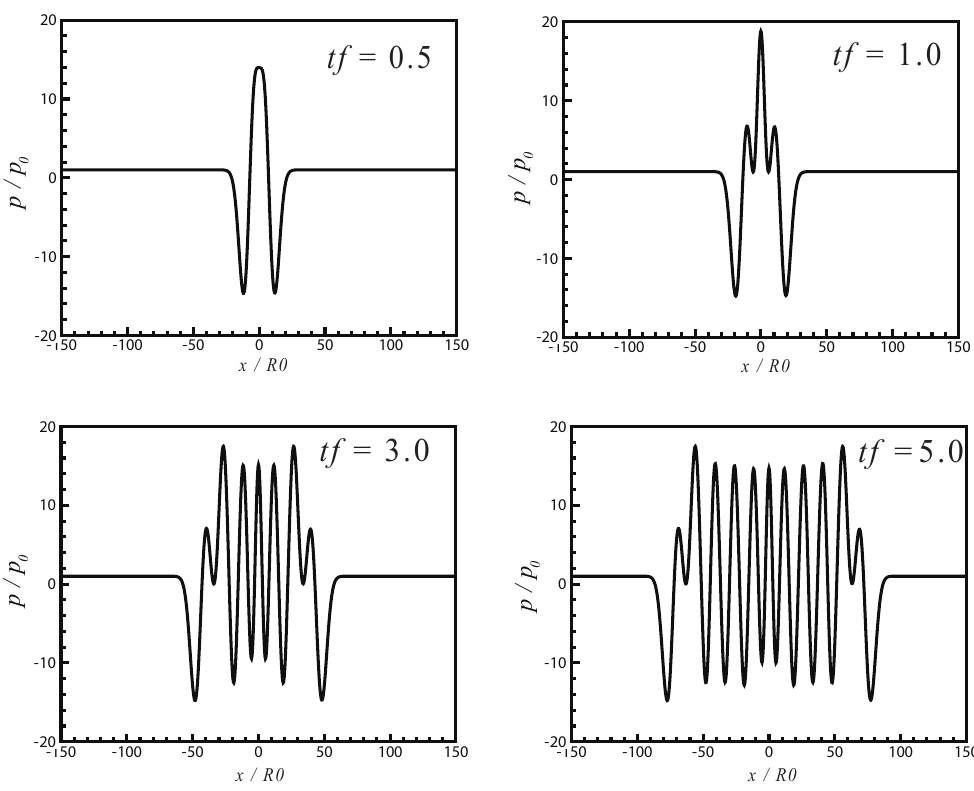
Figure 7. Single bubble oscillating: Pressure wave propagation induced from a continuous oscillating gas bubble at t ∗ = tf = 0.0,1.0,3.0, and